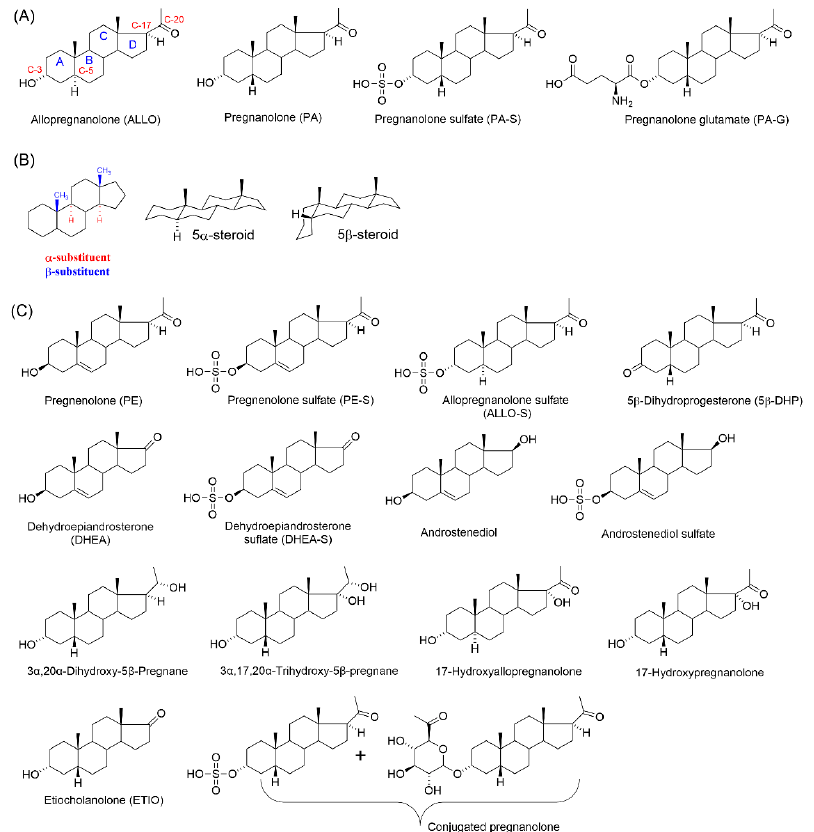
Figure 1. Structures of endogenous neurosteroids and neuroactive steroids relevant to this study. Steroidal ring numbering is in red; steroidal rings are in blue. ( A ) Structures of allopregnanolone, pregnanolone, pregnanolone sulfate, and pregnanolone glutamate. ( B ) Basics steroidal stereochem- istry: the schematic orientation of the substituents and a perspective representation of a planar 5 α steroid and a bent molecule of a 5 β steroid. Note that when the rings of a steroid are denoted as projections onto the plane of the page, the α substituent (dashed bond) lies below it and the β sub- stituent (bold bond) lies above the plane of the page. ( C ) Endogenous neurosteroids that were meas- ured in the hippocampal tissue of rats after i.p. administration of PA-G.